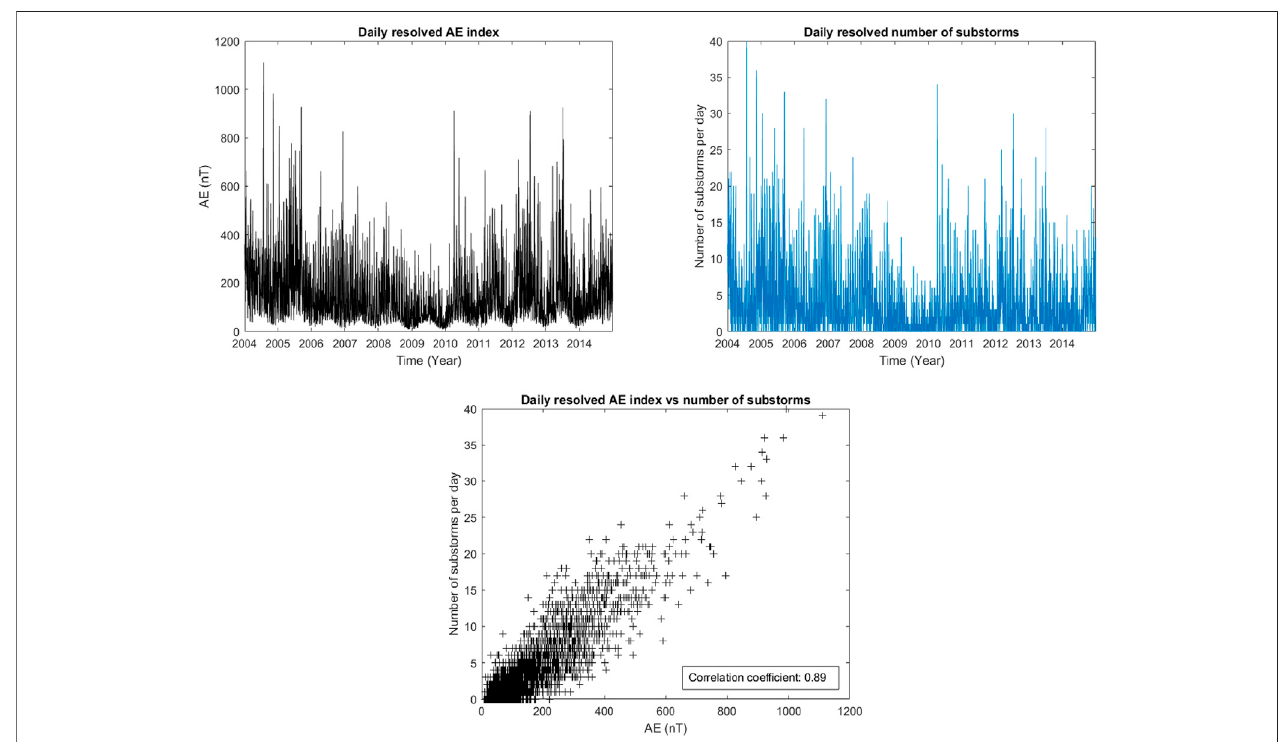
FIGURE 3 | Upper left plot: Daily resolved AE index (black line). Upper right plot: The number of substorms per day (blue line) based on Newell and Gjerloev (2011). Upper right plot: Scatter plot of the number of substorms per day and the daily resolve AE index. All panels include the period from 2004 to